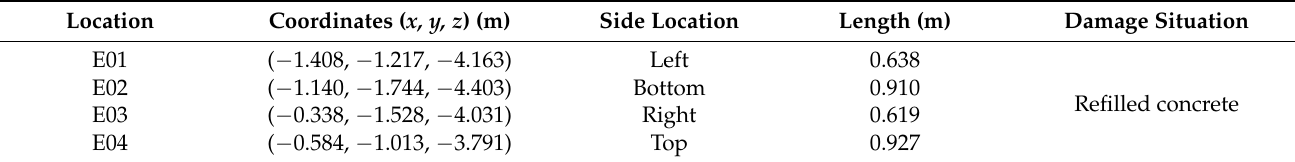
Table 7. Damage analysis at the bottom of the main beam.